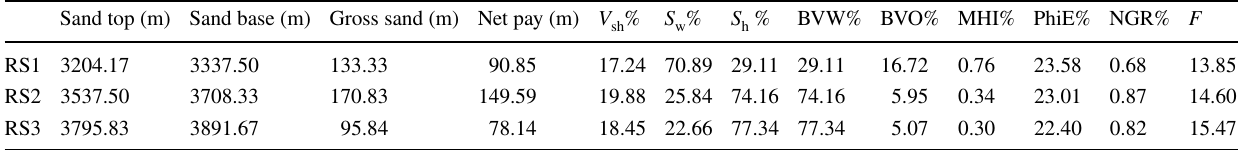
Table 2 Petrophysical properties of Well 2